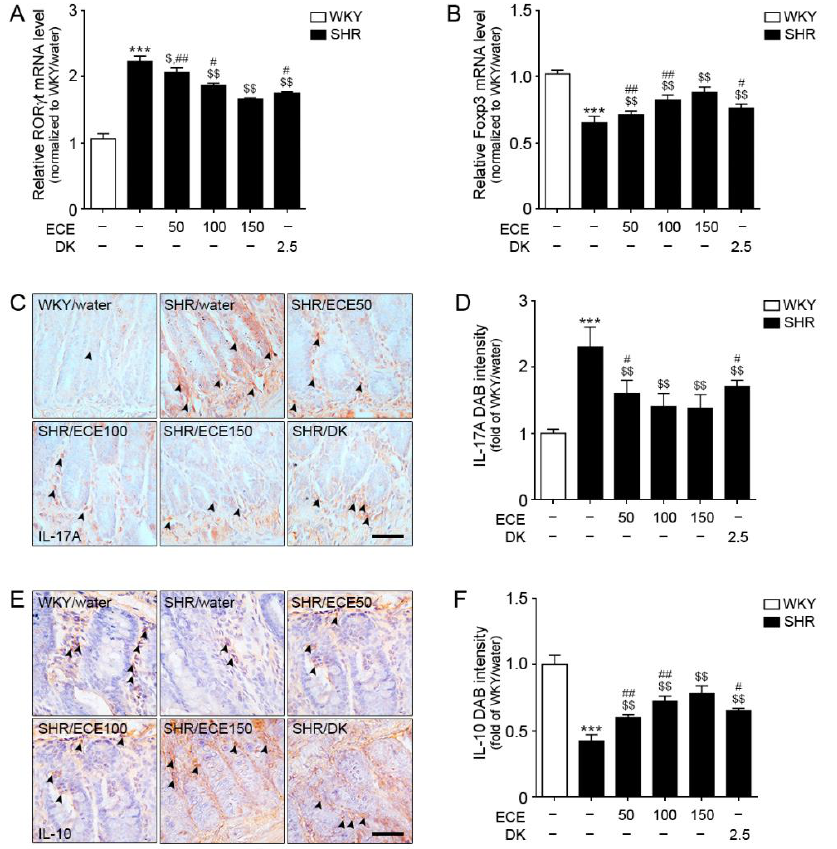
Figure 1. Regulatory effects of DK and ECE on Th17 and Treg cell levels in the intestine of SHRs. ( A ) In intestinal tissues, ROR γ t mRNA levels were increased by SHR/water. The addition of ECE and DK decreased the ROR γ t and Foxp3 mRNA levels. ( B ) The Foxp3 mRNA level in intestinal tissues was decreased following SHR/water and increased by ECE or DK treatment. ( C , D ) The IL-17A expression level in intestinal tissues was increased following SHR/water and decreased following ECE or DK treatment. ( E , F ) The IL-10 expression level in intestinal tissues was decreased following SHR/water and increased following ECE or DK treatment. For each of the 6 groups, n = 5. Scale bar = 100 µ